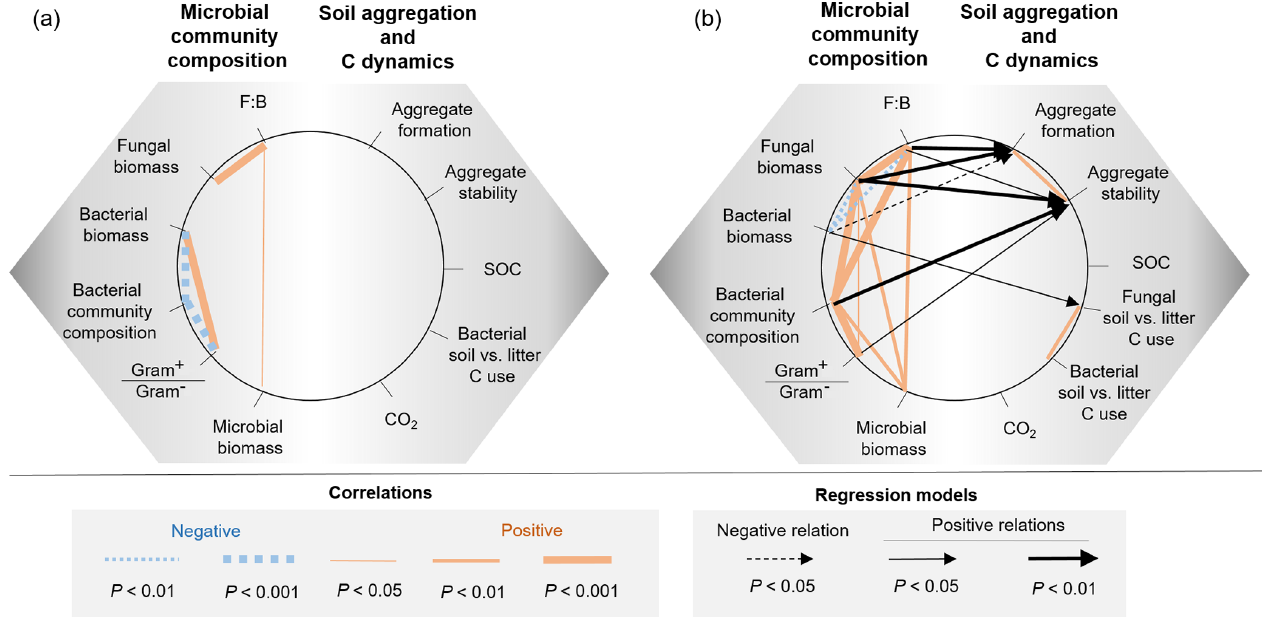
Figure 5. Relationships between microbial community composition and soil aggregation and C dynamics in the (a) bacterial-based and (b) fungal-based systems. Coloured lines indicate significant correlations (Spearman) among descriptors of microbial community compo- sition and soil functioning; for details of the statistical parameters see Tables A1 and A2. Black arrows indicate significant relationships between soil functioning variables and descriptors of the microbial community composition analysed by generalized linear models; for details of the statistical parameters see Table A3. Only significant relationships are